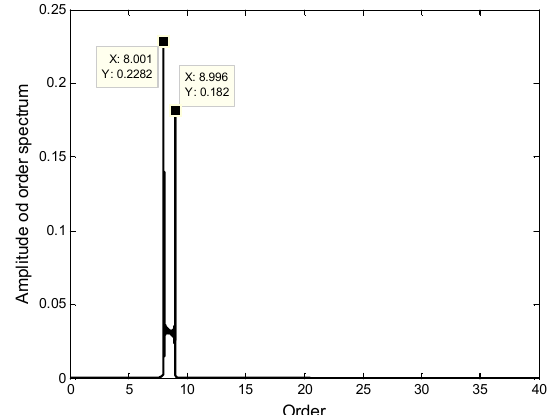
Figure 14. The angular-domain reconstruction signal of the under-sampled BTT signal using two BTT sensors under VRS.